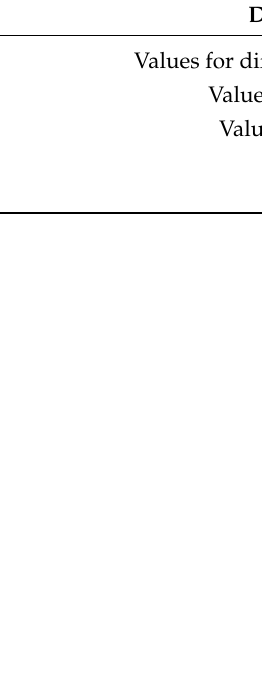
Table 12. The values for the sizes Difference between Pairs of Variants, k 30 Values for difference between pairs of variants, Values for shortest critical range, ( R P ) Values for difference Variant for superior rank, i ( i = 5) T9